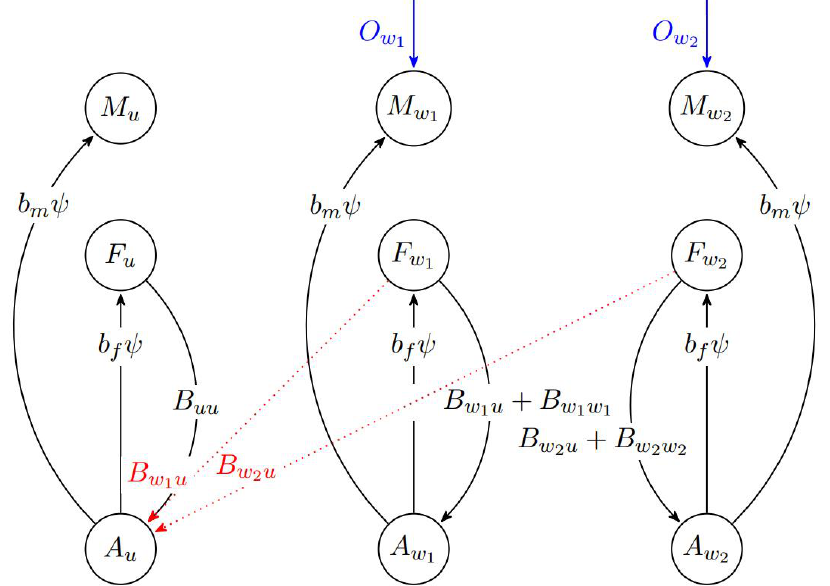
Figure 1. Schematic of the mosquito ecological model incorporating suppression and interventions to mitigate establishment. The circles represent specific mosquito populations, and the lines represent the transitions from one mosquito population to another, with the values within the lines representing transition rates between populations. The blue lines represent the release of male Wolbachia inoculated mosquitoes at rates O w or O w . The birthing rates capture the uninfected offspring that are produced 2 1 when the uninfected males mate with the uninfected females. When the w AlbB or w Mel-infected males mate with the uninfected females, inviable offspring are produced due to CI. Uninfected males mating with the infected w AlbB or w Mel-infected female produces a fraction of infected offspring by vertical transmission. Mating between w AlbB or w Mel-infected males with w AlbB or w Mel-infected females respectively produces a fraction of infected offspring. Mating between w AlbB-infected males (or w Mel-infected males) with w Mel females (or w AlbB females) resulted in inviable offspring due to